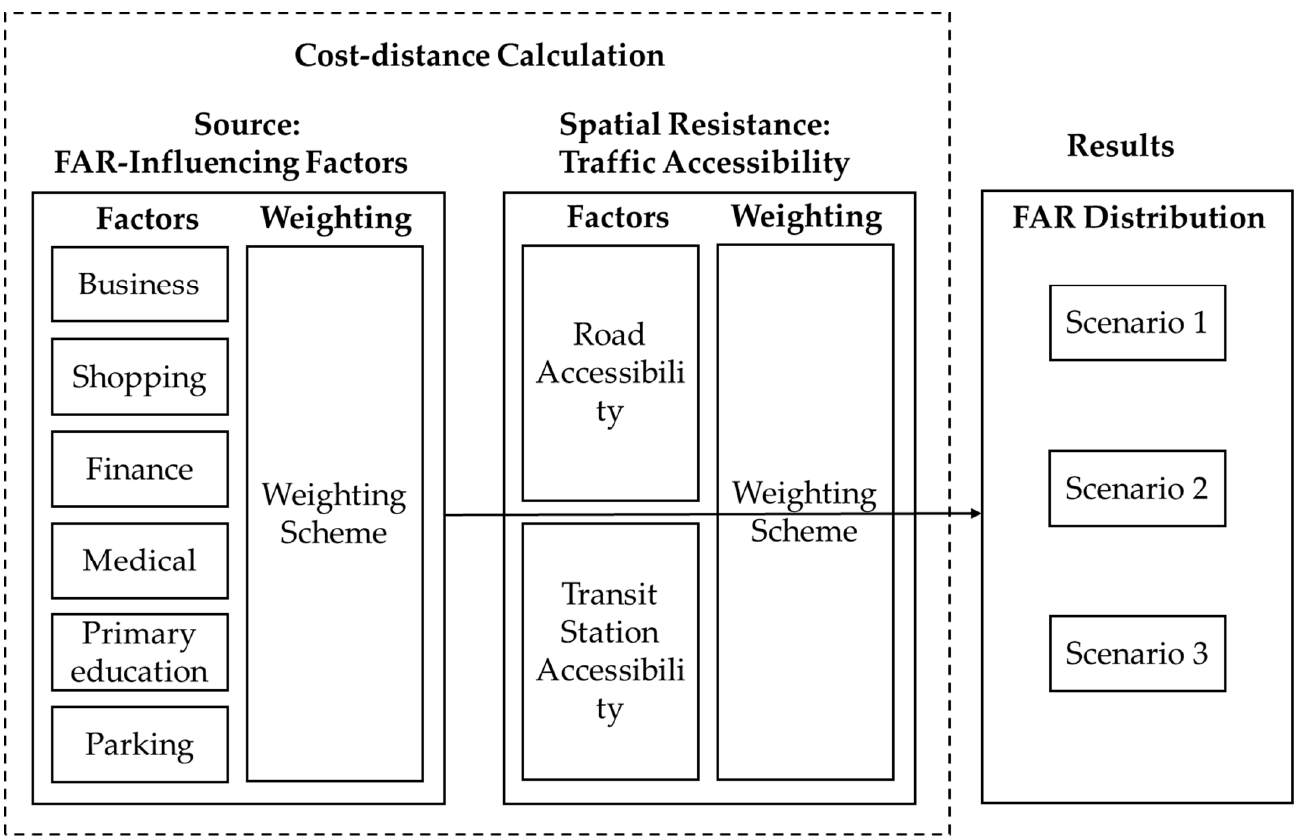
Figure 2. “Ideal” urban intensity scenario setting under applied location theory guidelines.